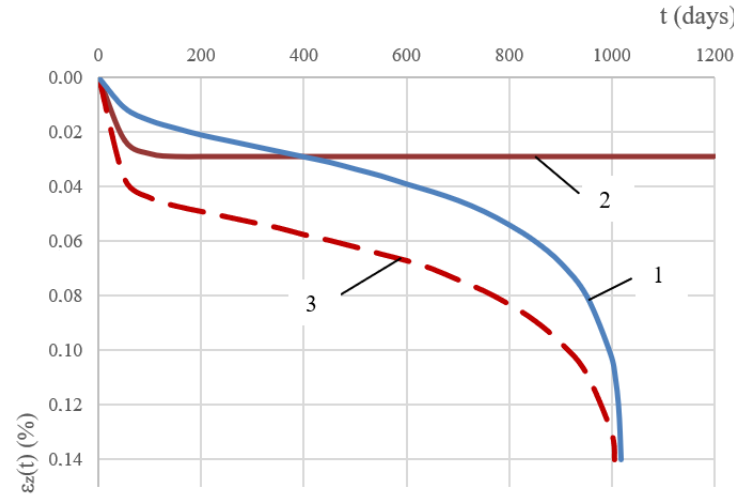
Figure 7. Shear deformations in a layer ε z –t : 1: determined using the Ter-Martirosyan model; 2: volumetric deformations determined using the Kevin–Voigt model; 3: total deformations determined using Formula (14).